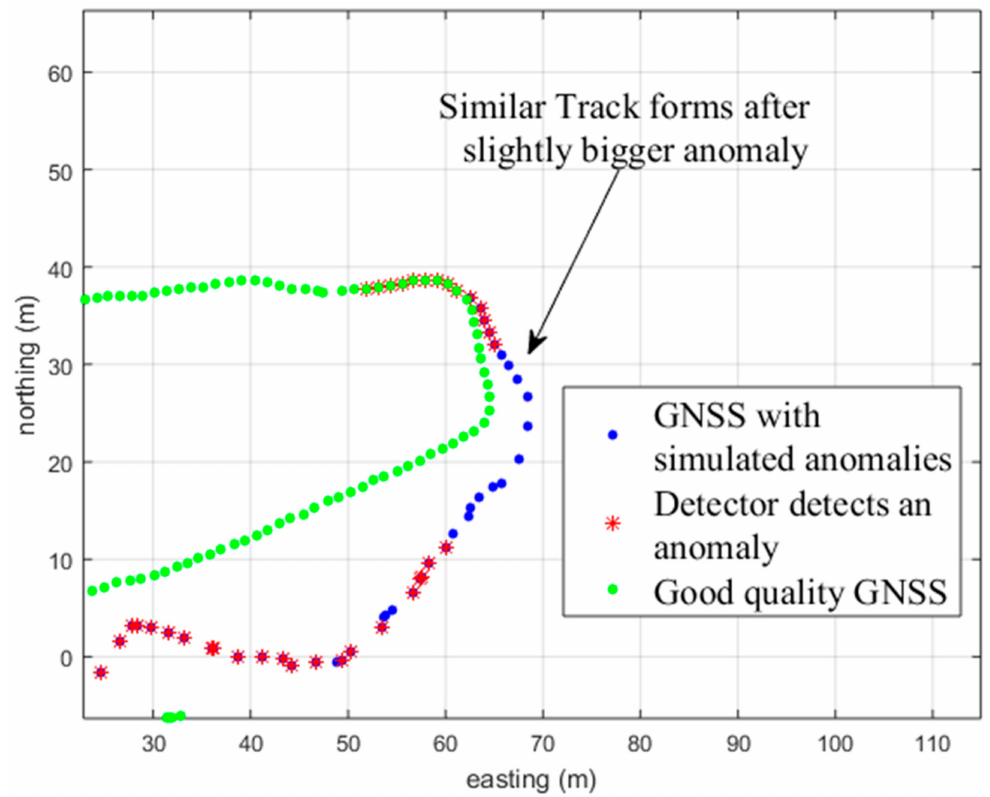
Figure 7. The green track shows the original good-quality GNSS track. The blue track is the GNSS track with the simulated anomalies, and the red bullets indicate a detection by the method used